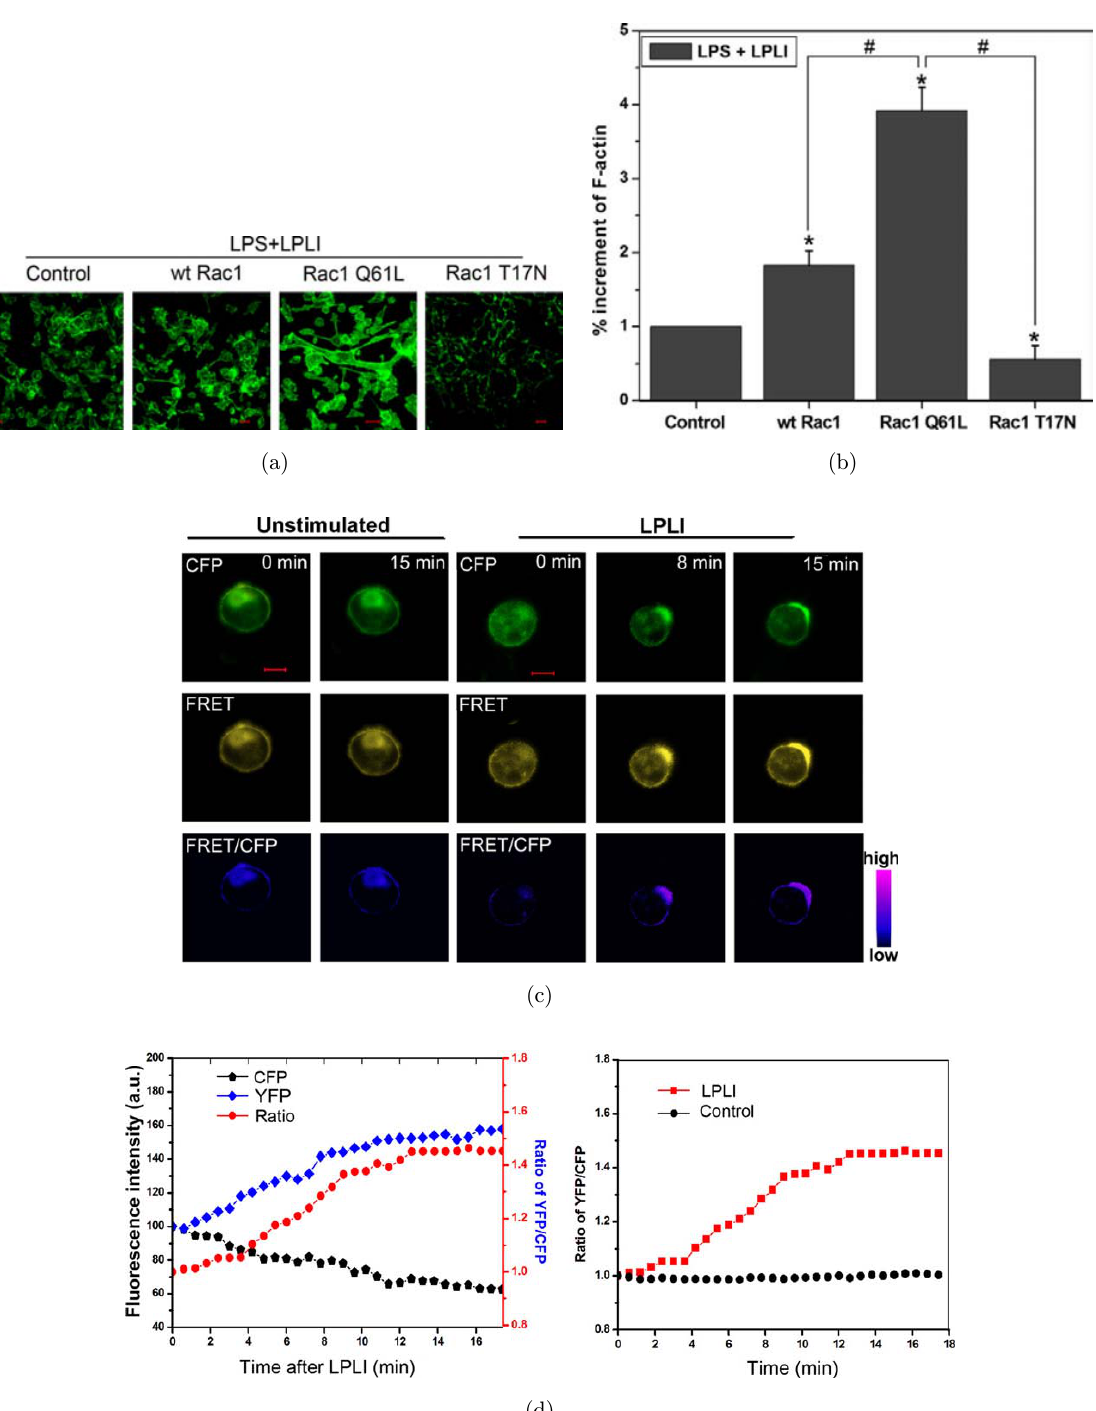
Fig. 2. LPLI-mediated microglial phagocytosis is a Rac-1-dependent actin-based process. (a) BV-2 cells were transfected with Rac1Q61L, Rac1T17N or wt-Rac1; G418-resistant cells were collected for further LPS stimulation. About 30 min after LPLI (20 J/ cm 2 ) treatment, cells were ¯xed with 4% paraformaldehyde and stained with FITC-labeled phalloidin to visualize F-actin (green) and confocal Z-stacks were acquired. Images shown are representative of approximately 100 cells. Bar ¼ 50 (cid:3) m. (b) Quantitative analysis of the levels of F-actin in (a). Data represent mean (cid:5) SEM ð n ¼ 6 Þ . (c) Representative °uorescence image series of